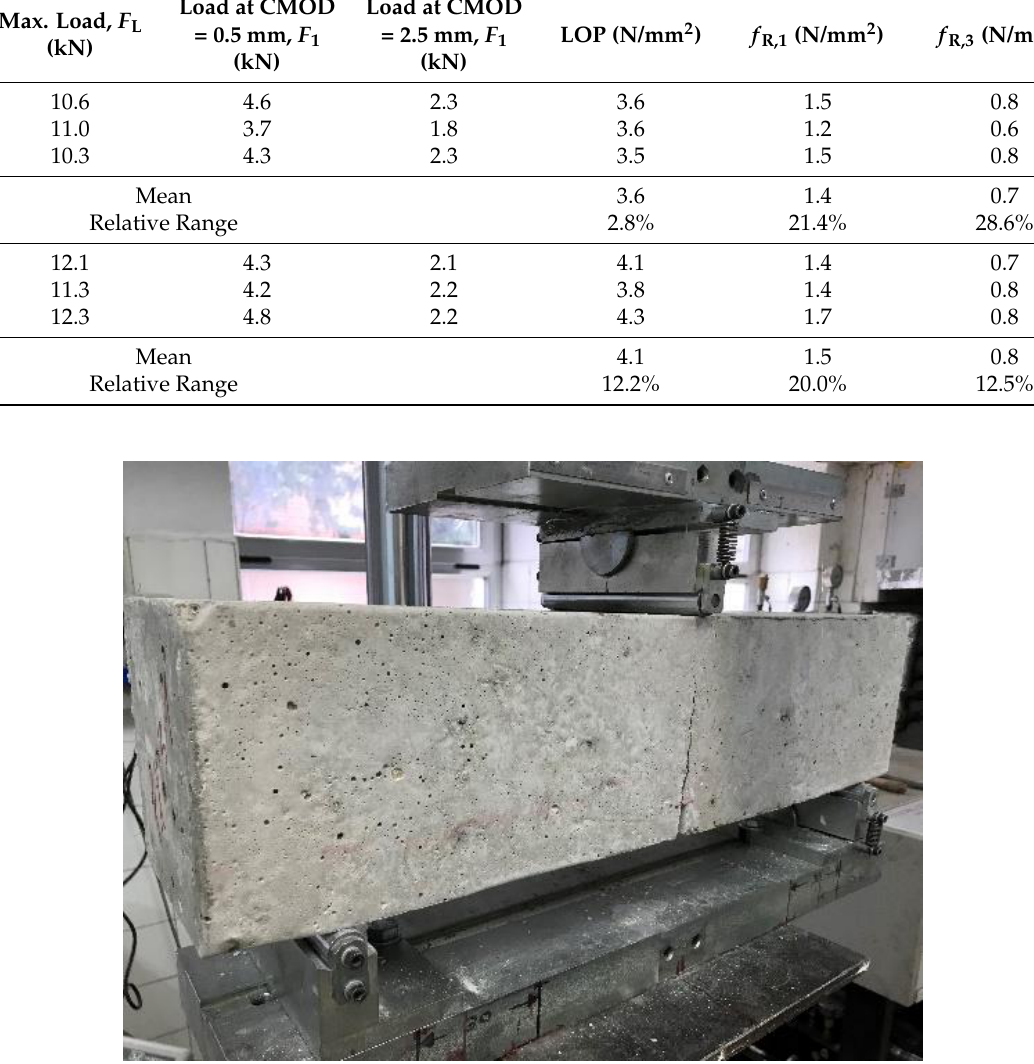
Figure 12. Location of the crack at the center spam in one of the tested beams (Picture by